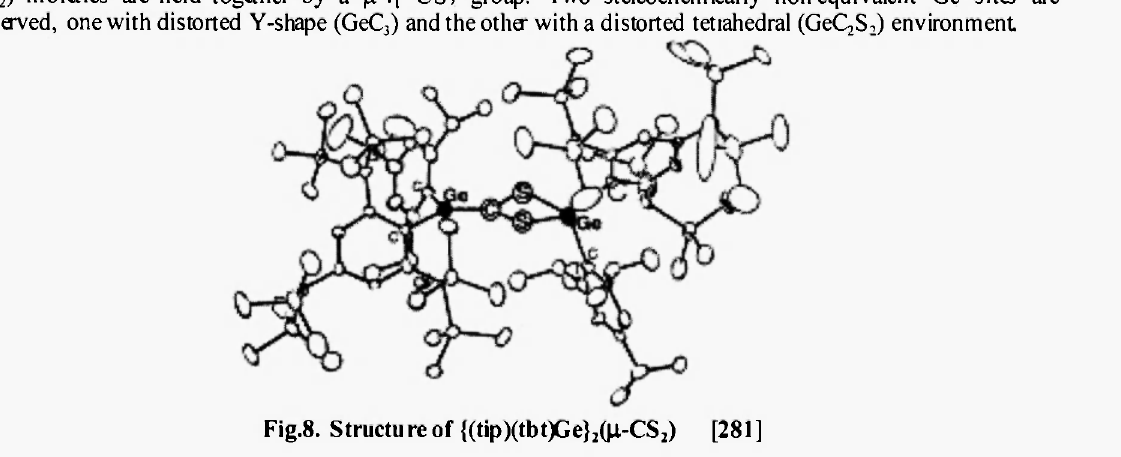
Fig.8. Structu re of {(tip)(tbt)Ge} 2 ^-CS 2 ) [281